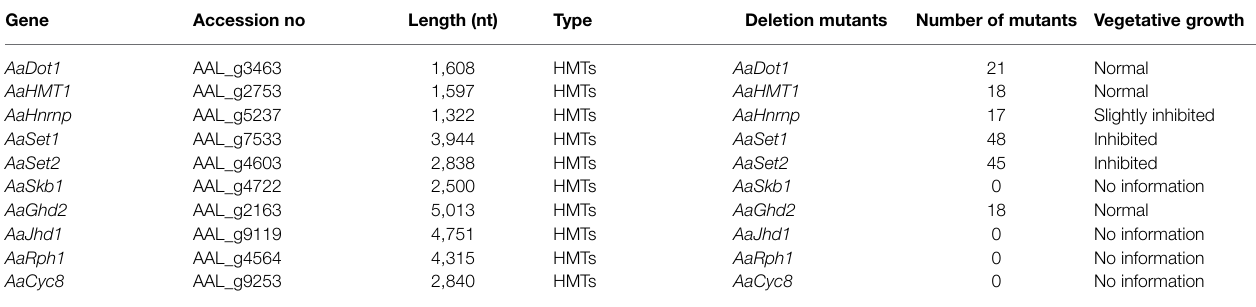
TABLE 1 | HMTs and HDMs in Alternaria